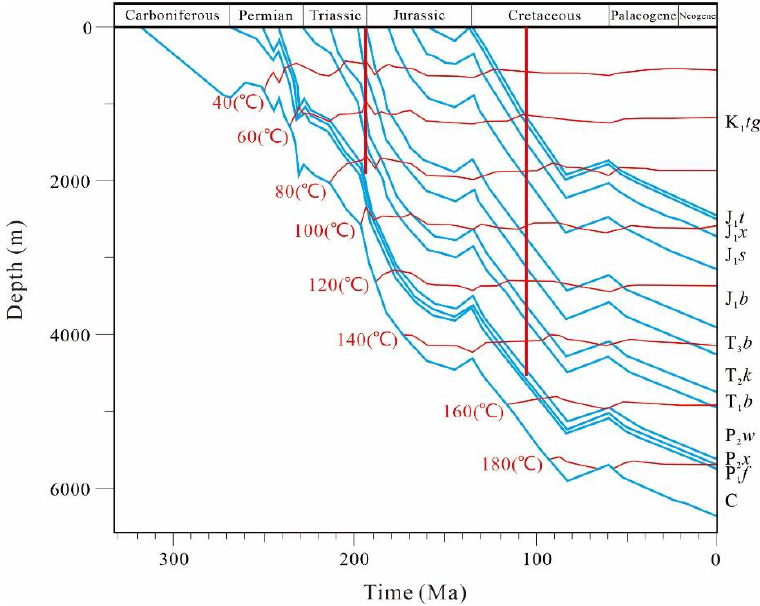
Figure 10. Burial history of well DT1.